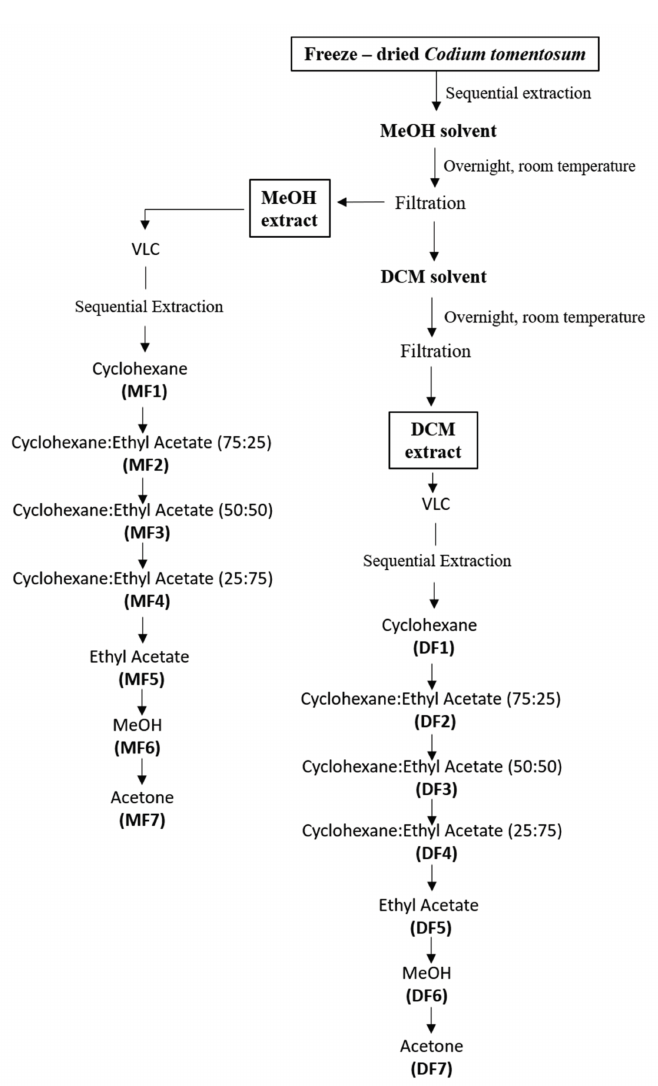
Figure 1. Extraction and fractionation flowchart of the green seaweed Codium tomentosum . The fractionation yields, the total phenolic content (TPC), and antioxidant capacity assessed through 2,2-diphenyl-1-picrylhydrazyl radical (DPPH) scavenging activity, oxygen radical absorbance capacity (ORAC), and ferric reducing antioxidant power (FRAP) assays of the di ff erent fractions obtained from the green seaweed C. tomentosum are summarized in Table 1. Table 1. Fractionation yields, TPC, and antioxidant capacity of Codium tomentosum fractions. Crude